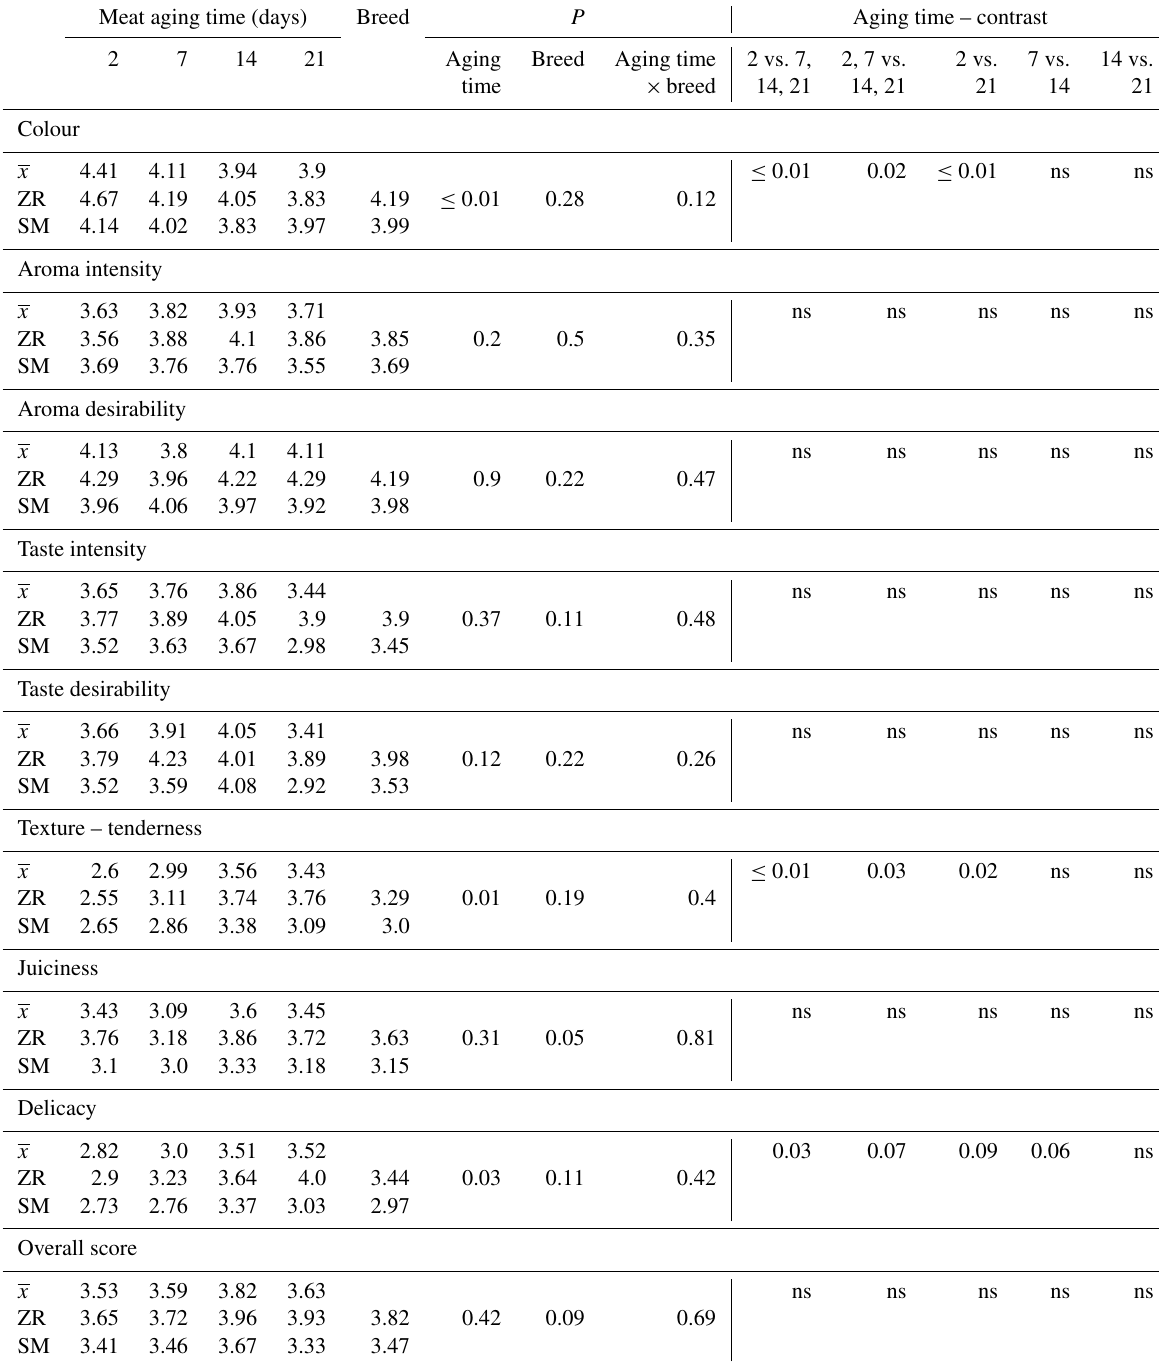
Table 2. Effect of breed on organoleptic characteristics of meat during aging. Meat aging time (days) Breed P Aging time – contrast 2 14 21 Aging Breed Aging time 2 vs. 7, 2, 7 vs. 2 vs. 14 vs. ×